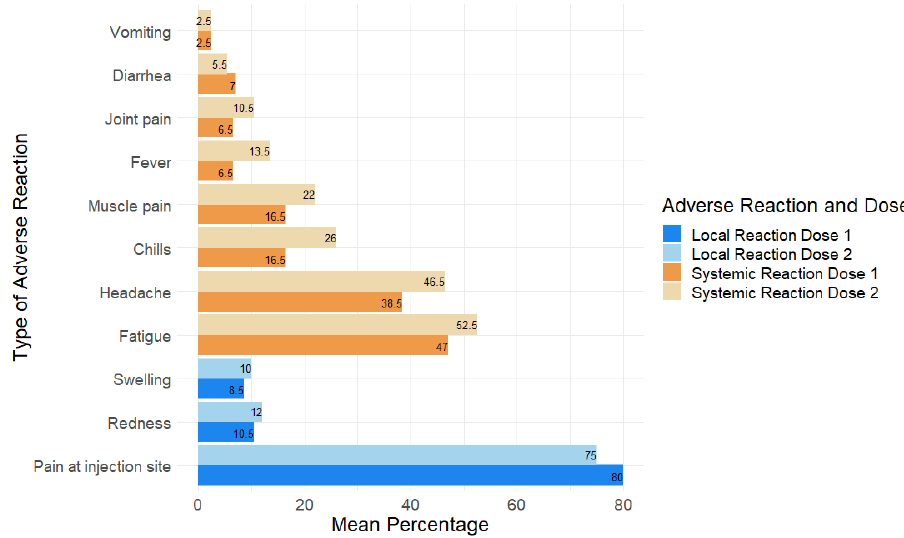
Figure 5. Local and systemic adverse reactions to the vaccine.